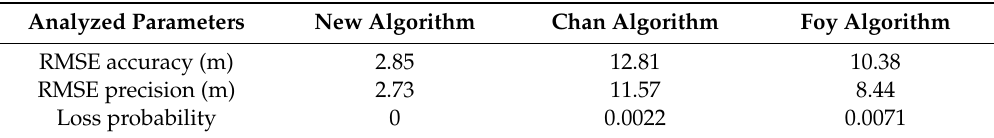
Table 3. Results of comparative analysis when all devices were deployed within one corridor with poor geometry.